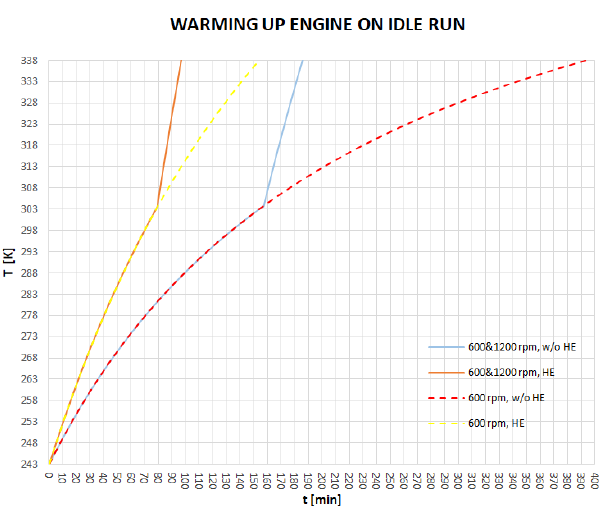
Fig. 8. Warming up diesel engine diagrams from –30°C [243.15 K] (HE – with heat exchanger; w/o HE – without heat exchanger) The engine warm-up from –30°C at 600 rpm under idle condition is shown using dashed lines. Red colour without additional heat source, and yellow with heat exchanger. In addition, after the engine reached +30°C, the effect of in- creasing the speed of rotation to 1200 rpm on the heating time was checked (continuous lines of red and